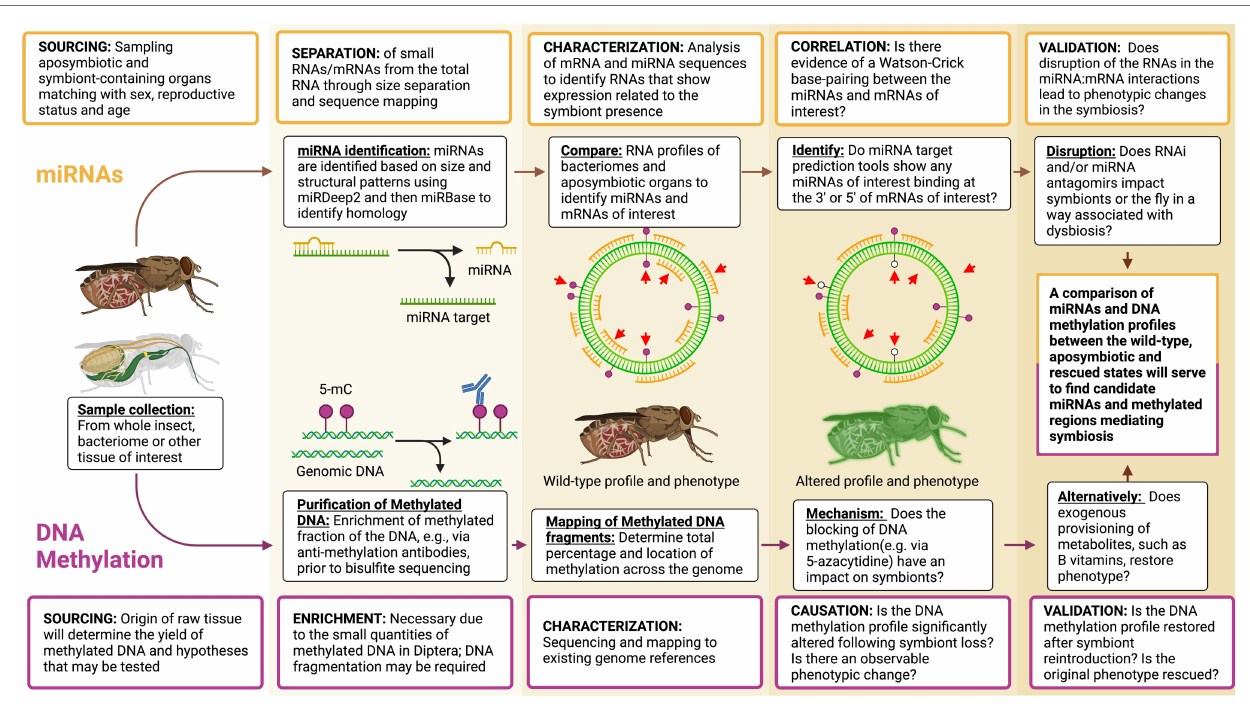
FIGURE 2 | Flow chart for the empirical analyses of epigenetic mechanisms mediating the Wigglesworthia -tsetse fly symbiosis. Of primary importance is the establishment of wild-type miRNA and methylation profiles and phenotypes followed by the characterization of altered states. If altered states are fully or partially rescued by restoration of the epigenetic mechanism through either the reintroduction of the symbionts and/or their provisioned metabolites, then there is evidence in favor of epigenetics mediating symbiosis. Distinct branches highlight methodology for the detection of miRNAs and DNA methylation impact toward symbiosis, while smaller boxes feature comments on the relevant methodology. Red arrows indicate differences in nucleic acid profiles upon comparison of sample